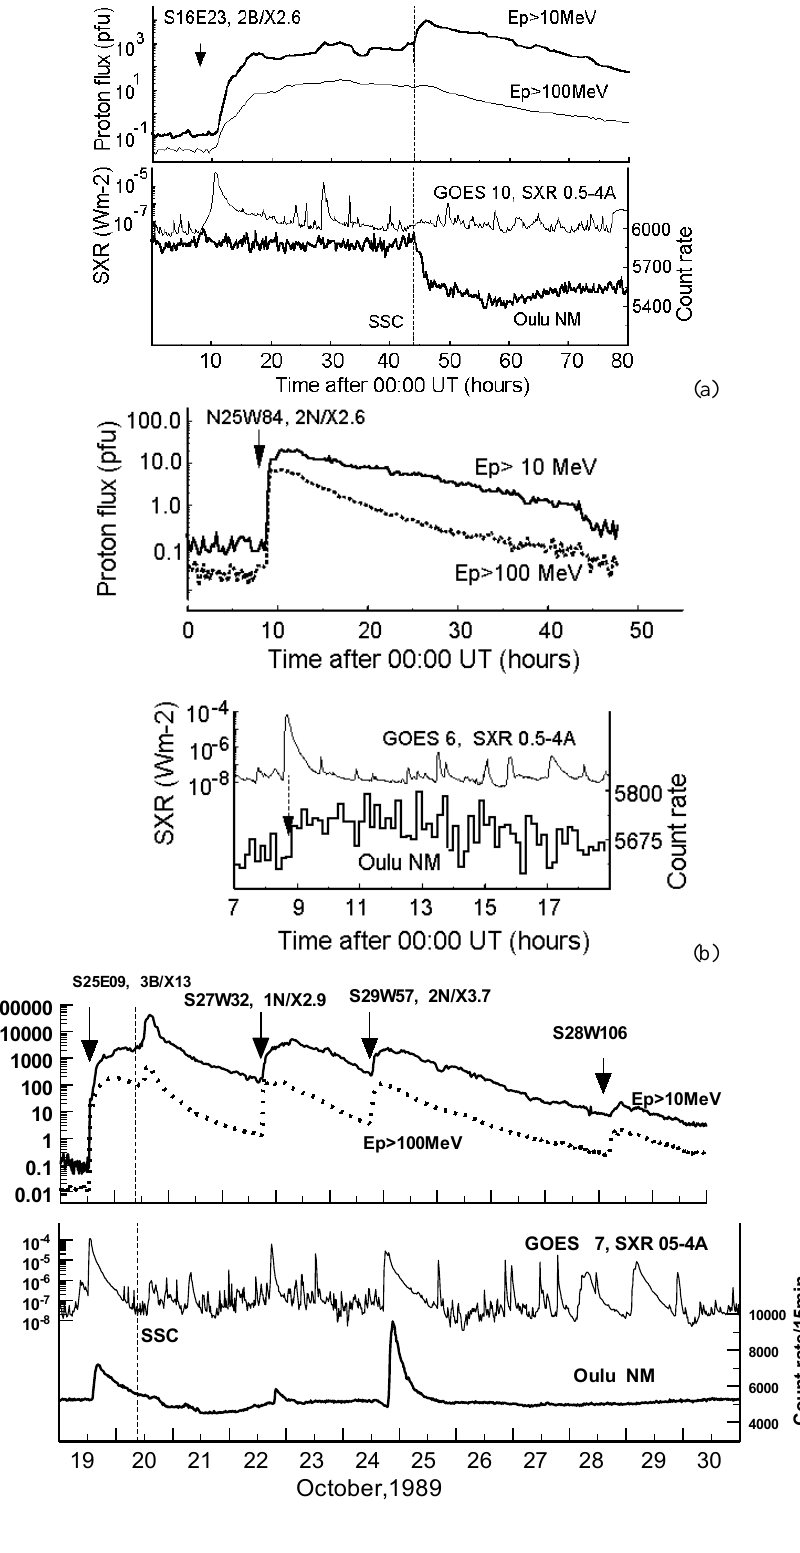
Fig. 1. Typical examples of large solar proton events which occurred on 24 September 2001, 25 July 1989 and during the time interval from 18 October to 31 October 1989,